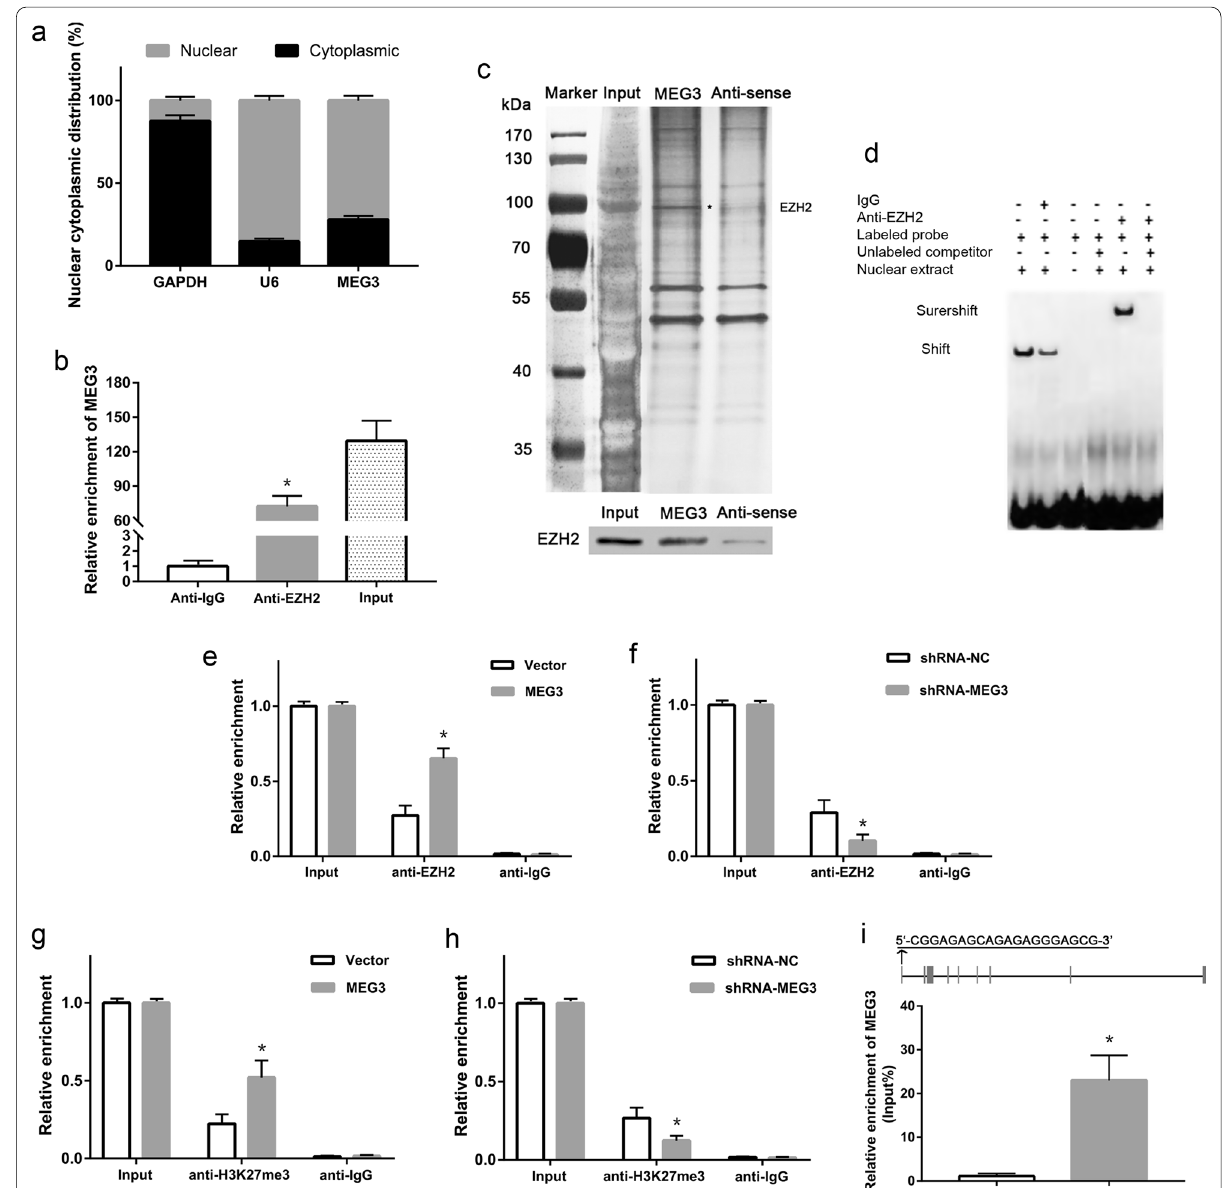
Fig. 5 MEG3 regulated the expression of RASA1 via EZH2. a Cytoplasmic and nuclear localization of MEG3. b Determination of the ability of EZH2 protein to interact with MEG3 via RIP assay. c Identification of MEG3-bound proteins by RNA pulldown assay. d Verification the direct binding of EZH2 protein and MEG3 using EMSA assay. e and f ChIP assay for the recruitment of EZH2 at the RASA1 promoter gene by MEG3. g and h Analysis of the effects of MEG3 on the levels of H3K27me3 at the RASA1 promoter using ChIP assay. i GA-enriched motifs (chromatin-interacting sequences) at the 5’-end region of MEG3 sequence. Interactions of MEG3 with the promoter sequence of the RASA1 gene using DNA pulldown assay. *P <